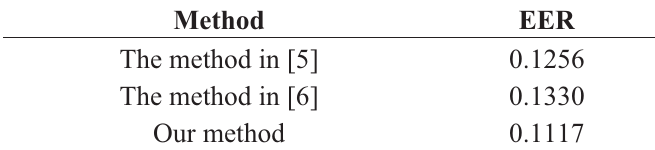
Table 2. The performance of finger vein identification by different ROI localization methods.